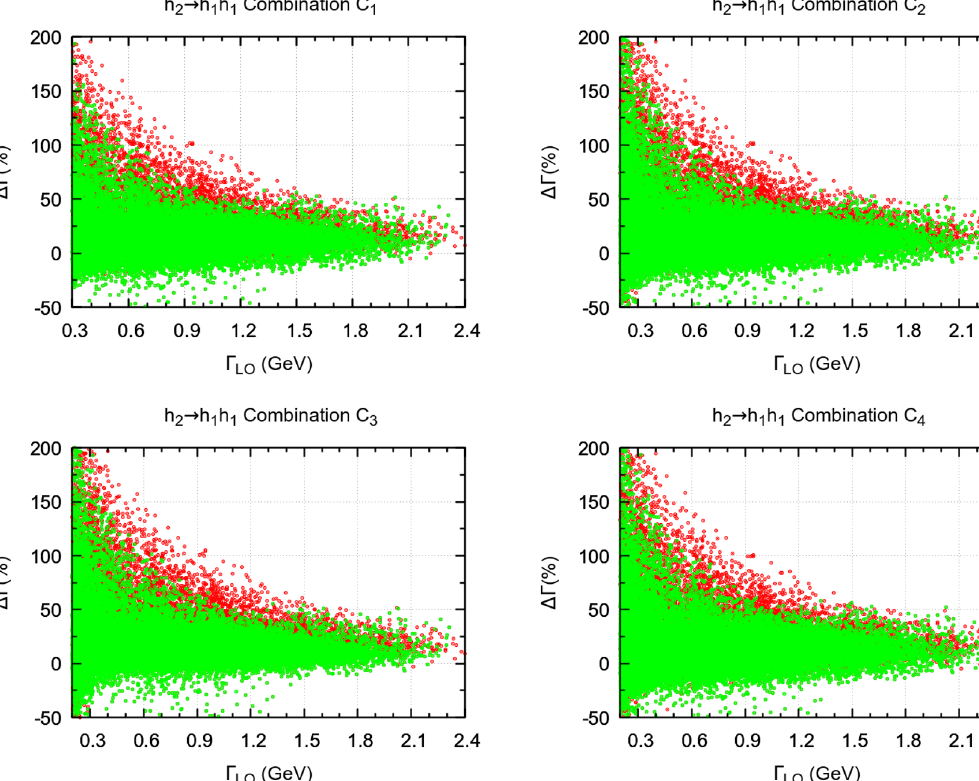
Figure 5 . ∆Γ h in percentage as a function of Γ LO , for the combinations C 1 (top left), h 2 → h 1 h 1 2 → h 1 h 1 C 2 (top right), C 3 (down left) and C 4 (down right). Only the interval 0 . 1 GeV < Γ LO < 2 . 4 GeV is shown. All points correspond to µ R = 350 GeV; the color conventions are those of figure